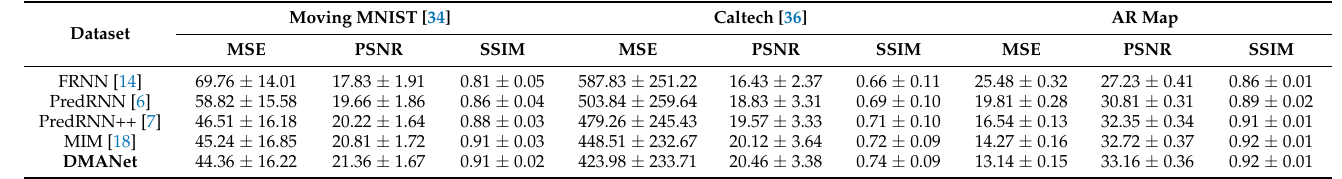
Table 3. Comparisons with different